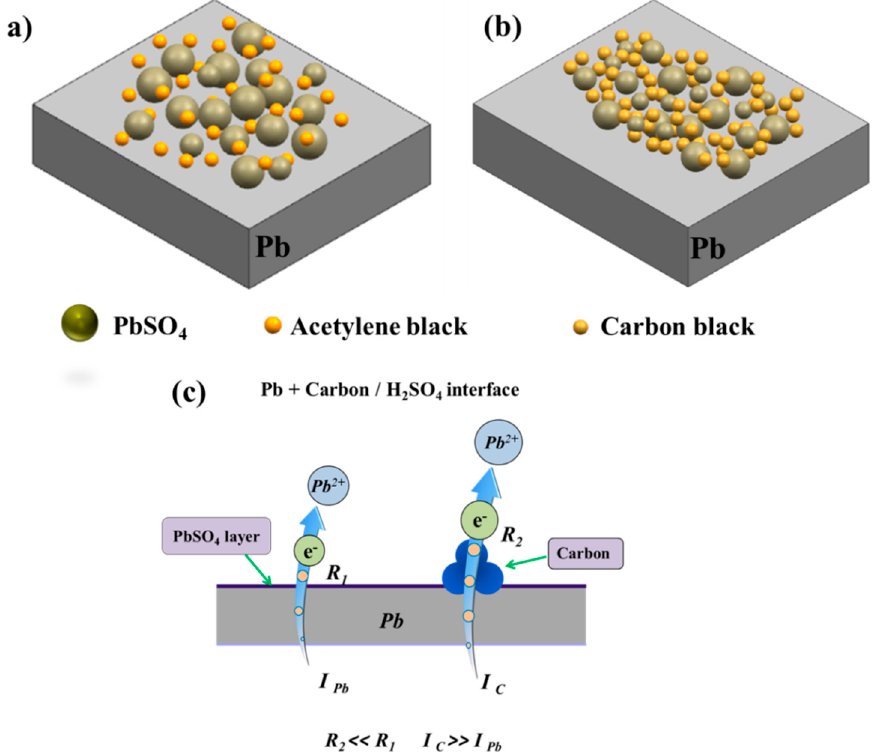
Figure 7. ( a , b ) Schematic diagram of acetylene black and carbon black on the negative plate under 100% DoD conditions, respectively. ( c ) Schematic diagram of ion migration through the Pb and carbon interfaces in the negative plate. (R 1 and I Pb are the resistance and current of ions passing through the interface of Pb/H 2 SO 4 , respectively. R 2 and I C are the resistance and current of ions passing through the interface of C/H 2 SO 4 ,